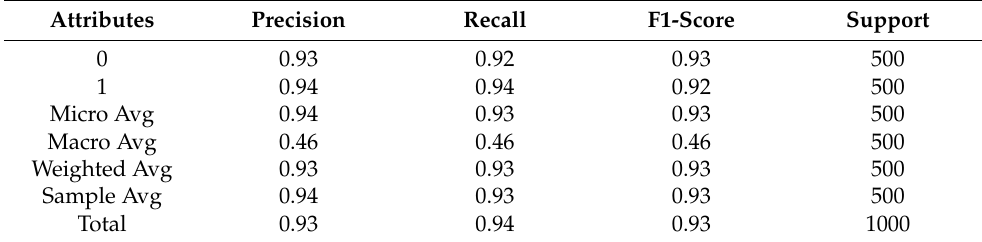
Table 1. Performance Measurement Parameters of the NN